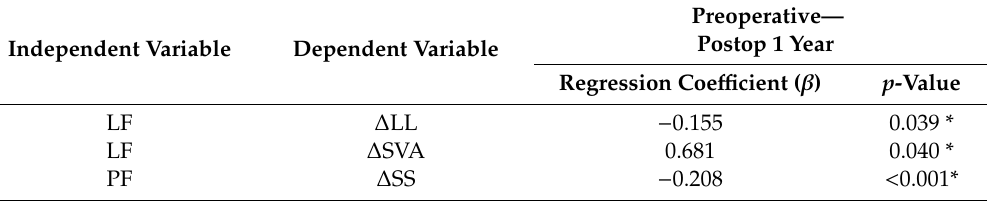
Table 3. Subgroup analysis to identify the cause–result relationship using linear regression analysis.